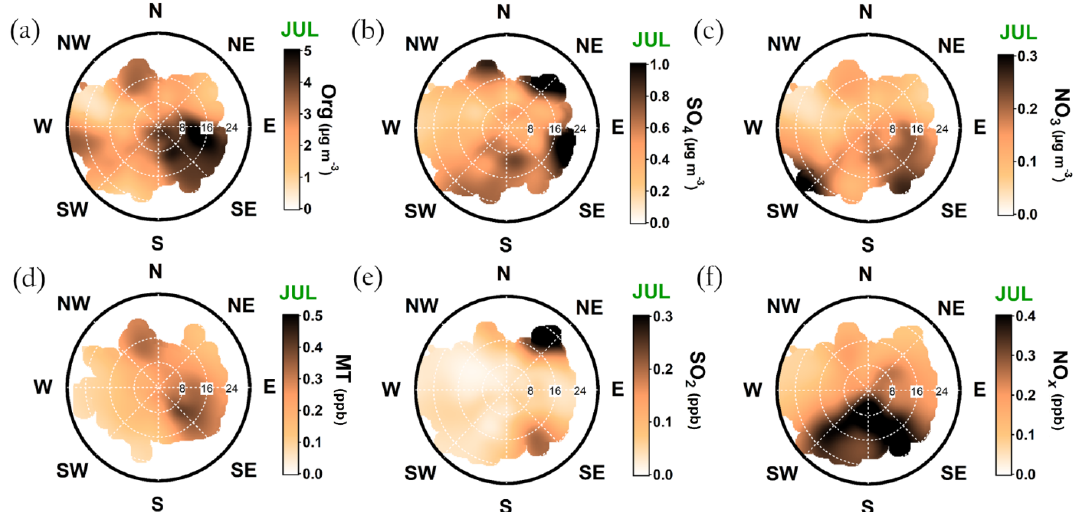
Figure A9. Openair polar plots for organic aerosol (a) , sulfate (b) , nitrate (c) , monoterpenes (d) , SO 2 (e) , and NO x (f) during July. The distance from the origin indicates wind speeds in kmh − 1 . The wind speed grid lines are presented with dashed white circles. The color scales represent the concentrations observed with each wind speed and direction combinations. As the figures do not indicate any likelihood of the wind speed and distance combinations, Fig. A1 is important to keep in mind while interpreting them. Briefly, N–NE–E is the least probable wind direction, whereas S–SW–W is the most likely. Wind speeds generally stay below 20kmh − 1